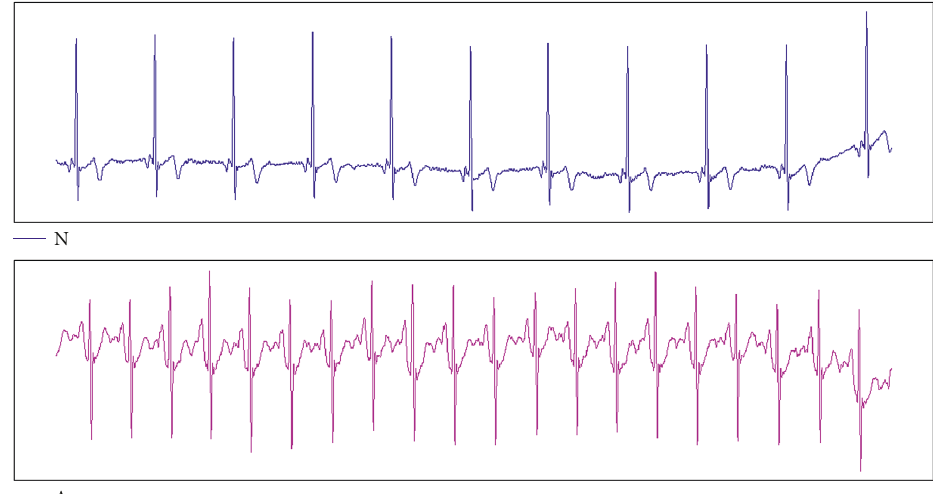
Figure 1: Normal ( N ) and abnormal ( A ) records from